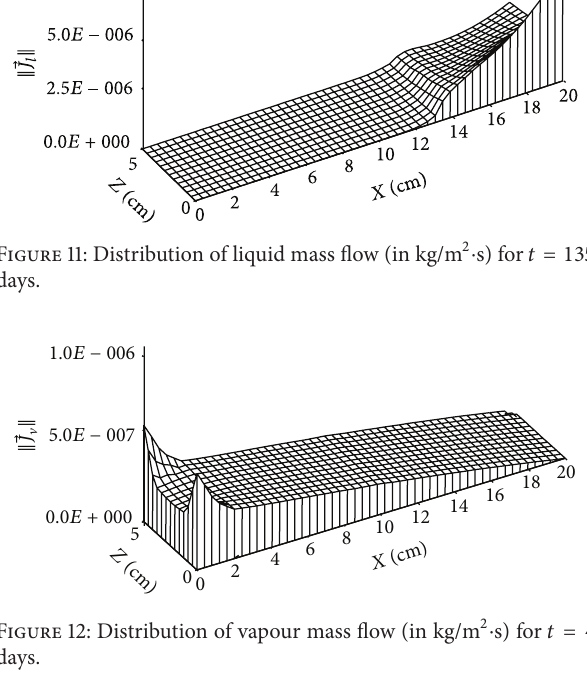
of condensation extends from this position towards ( 𝑥 = 12